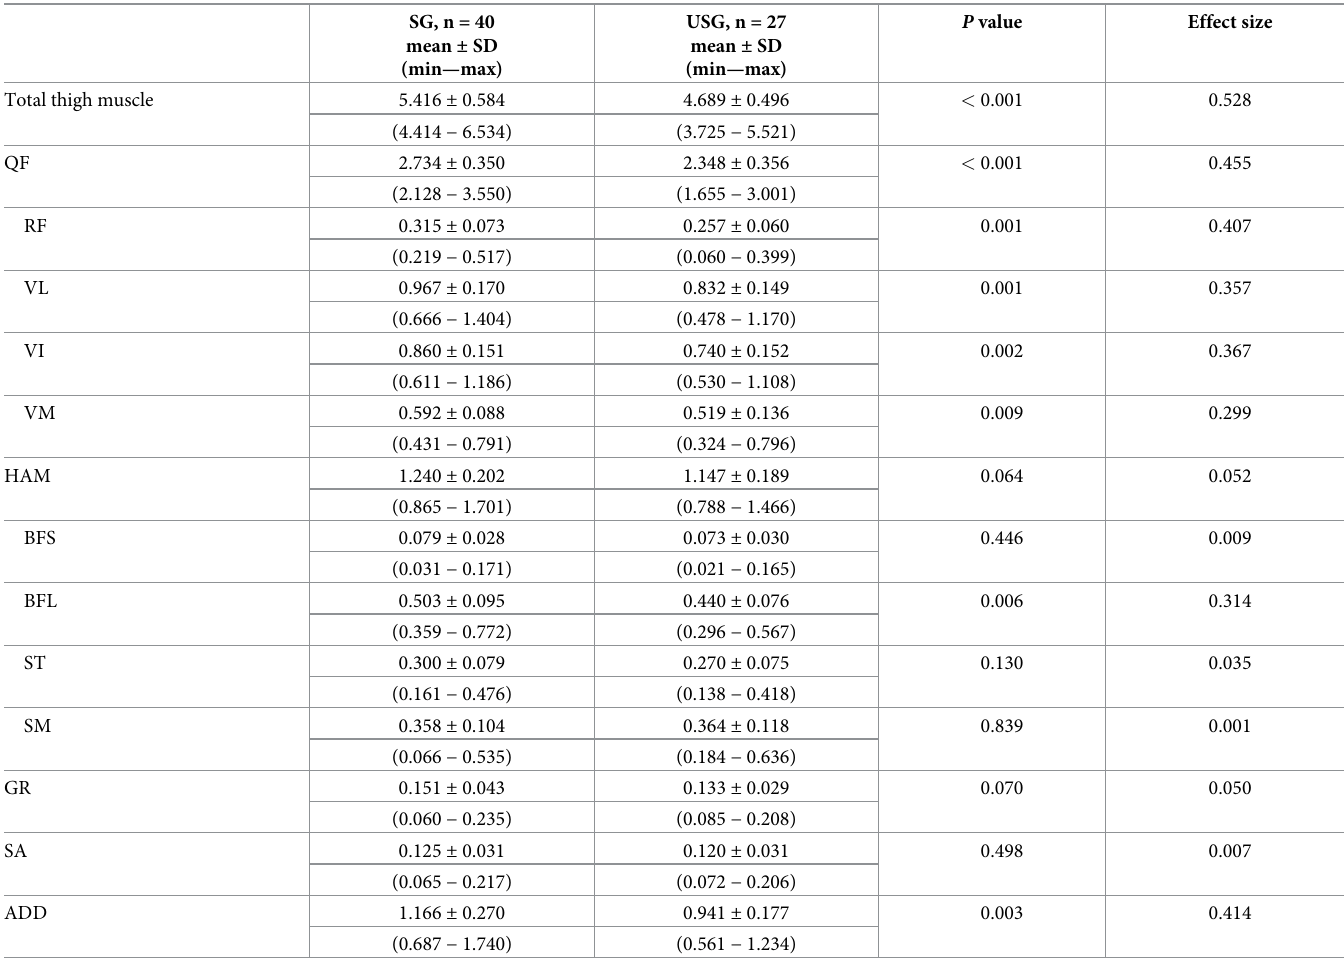
Table 3. Comparison of CSA/BM 2/3 values of individual mid-thigh muscles (cm 2 /kg 2/3 ) between SG and